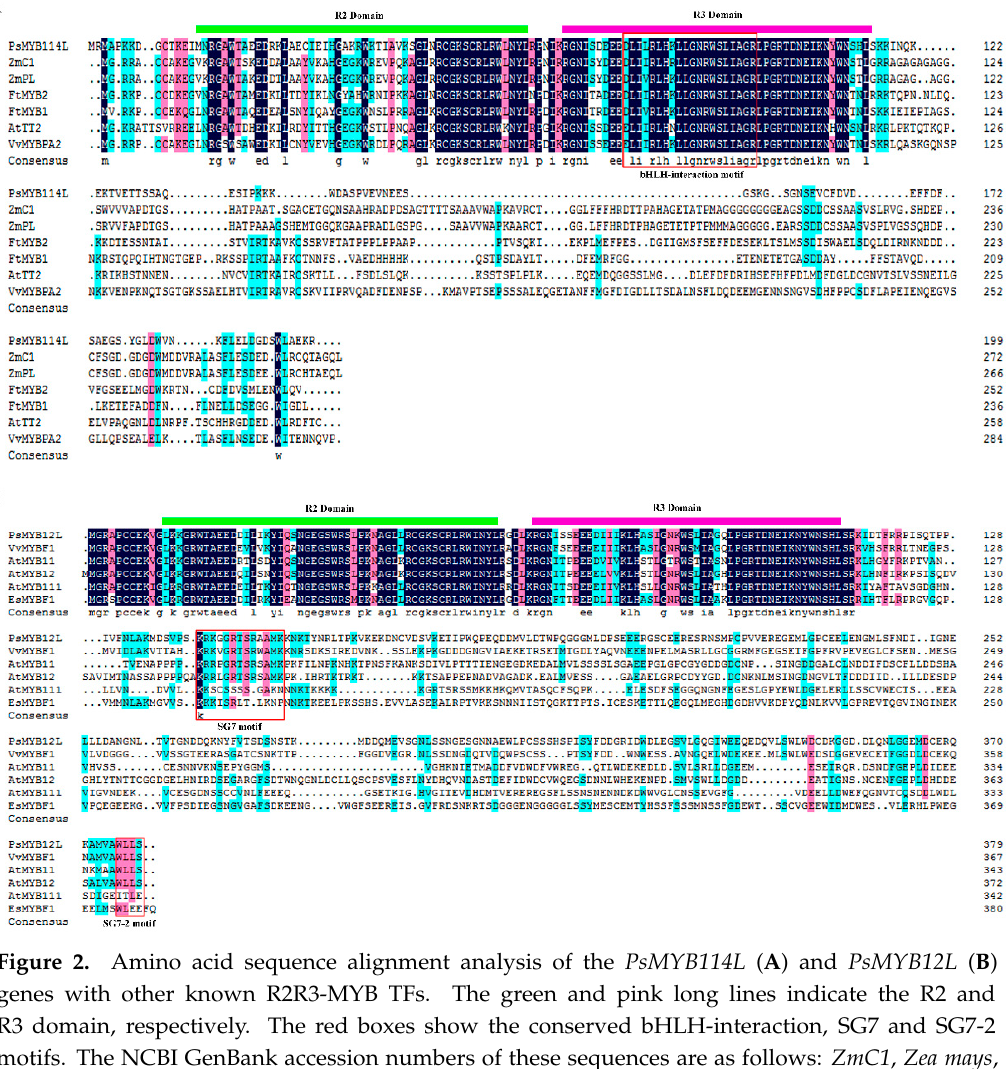
Figure 2. Amino acid sequence alignment analysis of the PsMYB114L ( A ) and PsMYB12L ( B ) genes with other known R2R3-MYB TFs. The green and pink long lines indicate the R2 and R3 domain, respectively. The red boxes show the conserved bHLH-interaction, SG7 and SG7-2 motifs. The NCBI GenBank accession numbers of these sequences are as follows: ZmC1 , Zea mays , AF320613.3; ZmPL , Zea mays , NM_001112415.1; FtMYB2 , Fagopyrum tataricum , JF313346.1; FtMYB1, Fagopyrum tataricum , JF313344.1; AtTT2 , Arabidopsis thaliana , NM_122946.3; VvMYBPA2 , Vitis vinifera